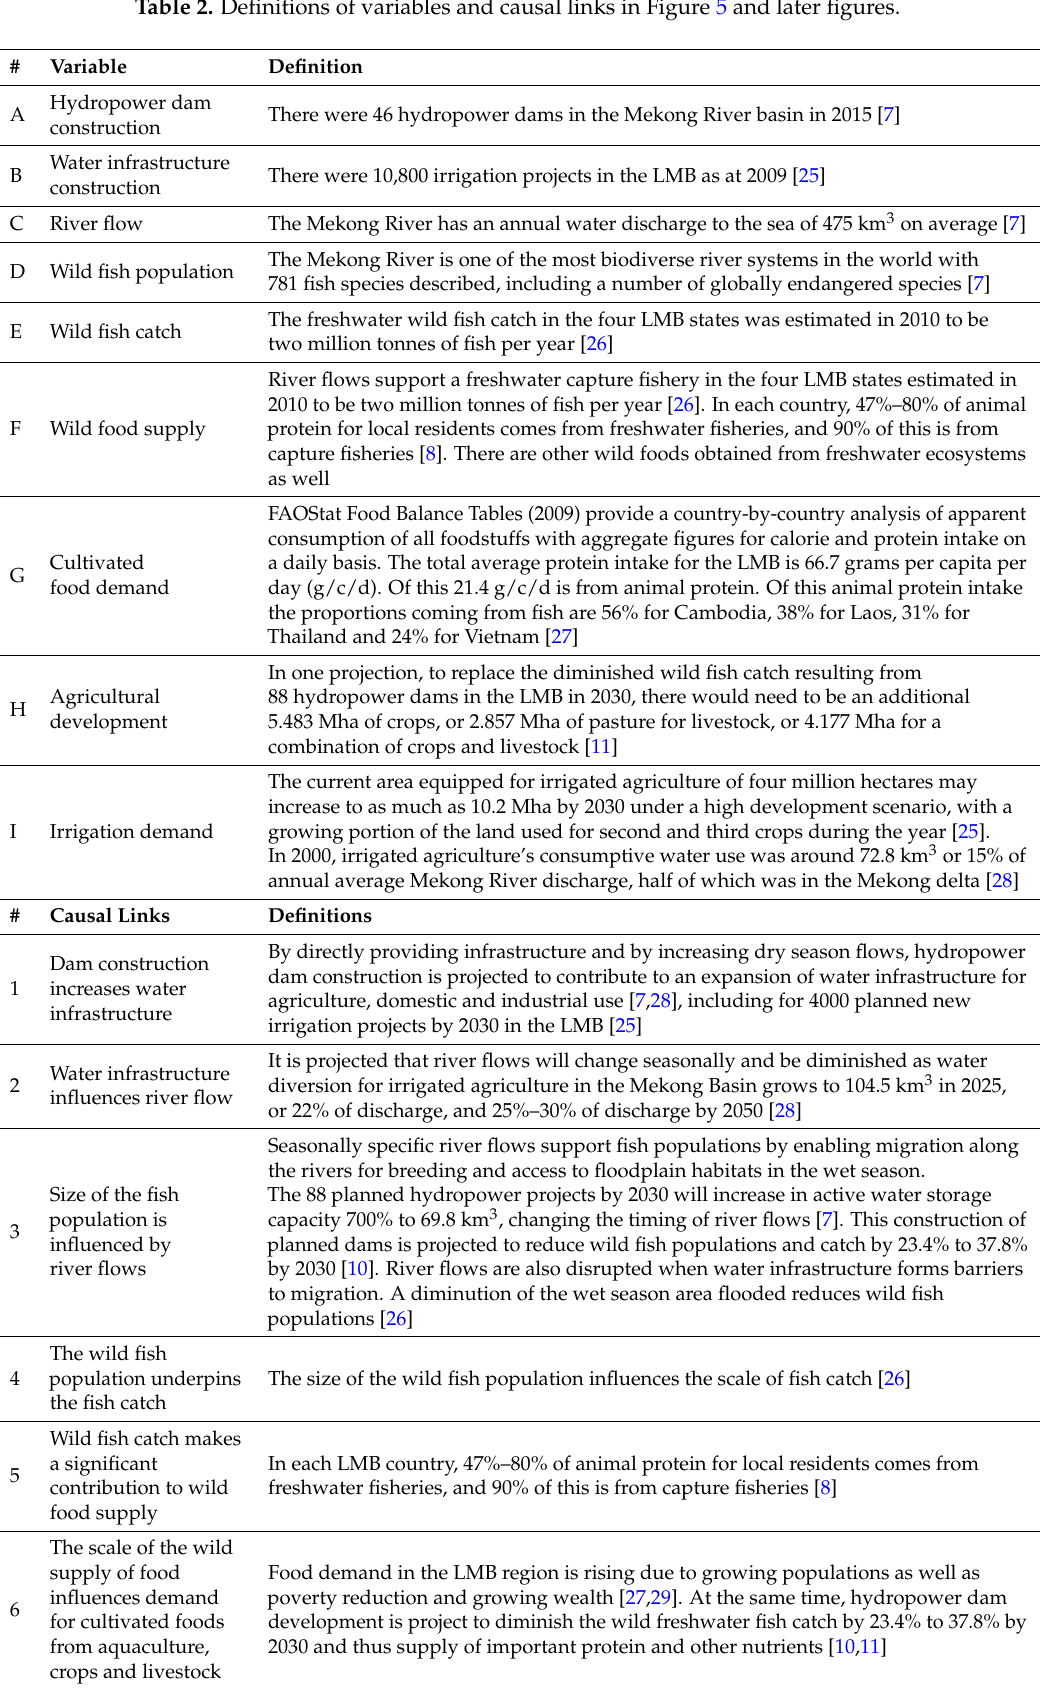
Table 2. Definitions of variables and causal links in Figure 5 and later